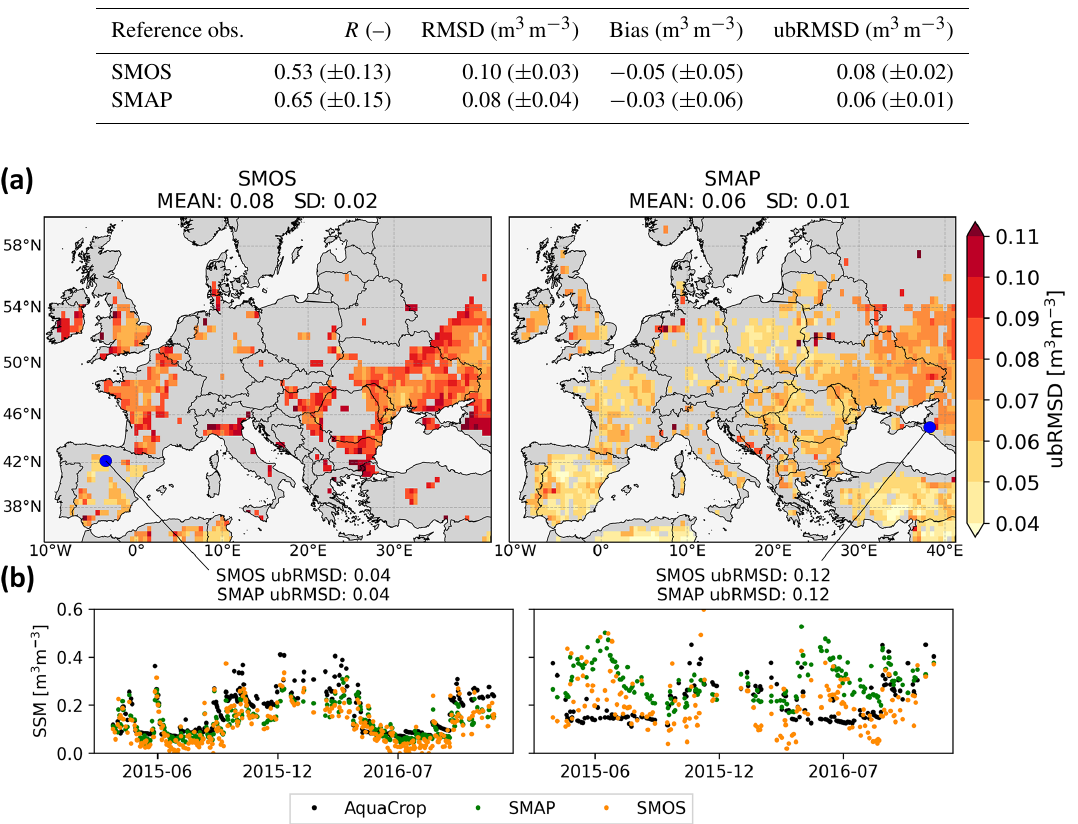
Figure 1. (a) The ubRMSD of SIM1 AquaCrop SSM compared to SMOS (left) and SMAP (right) retrievals for April 2015 through December 2016. The spatial mean and standard deviation are indicated in the titles (MEAN and STDEV). Gray areas correspond to pixels where the number of satellite retrievals is smaller than 100. (b) The SSM time series of the two pixels marked by blue dots in panel (a) , with the title indicating the ubRMSD (m 3 m − 3 ) against SMOS and SMAP for each